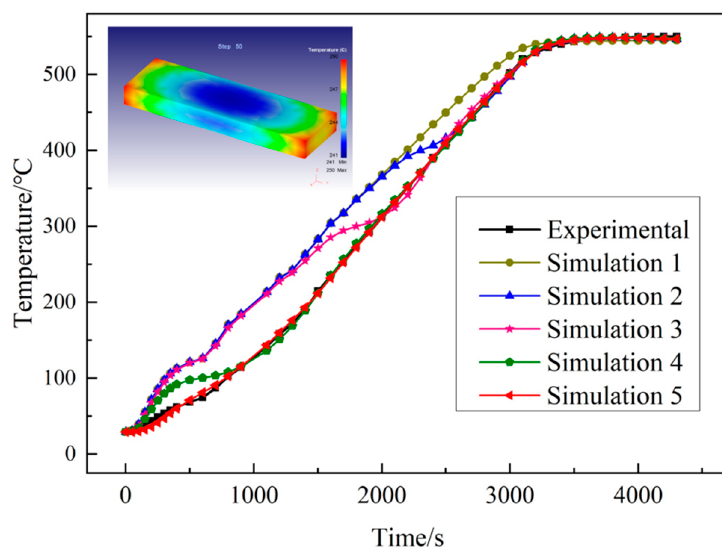
Figure 6. Temperature curve in the heating process.